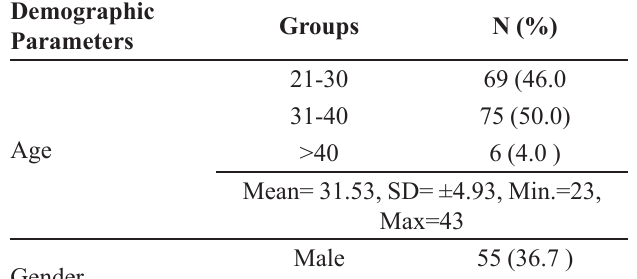
TABLE I - Socio-demographic data of study participants